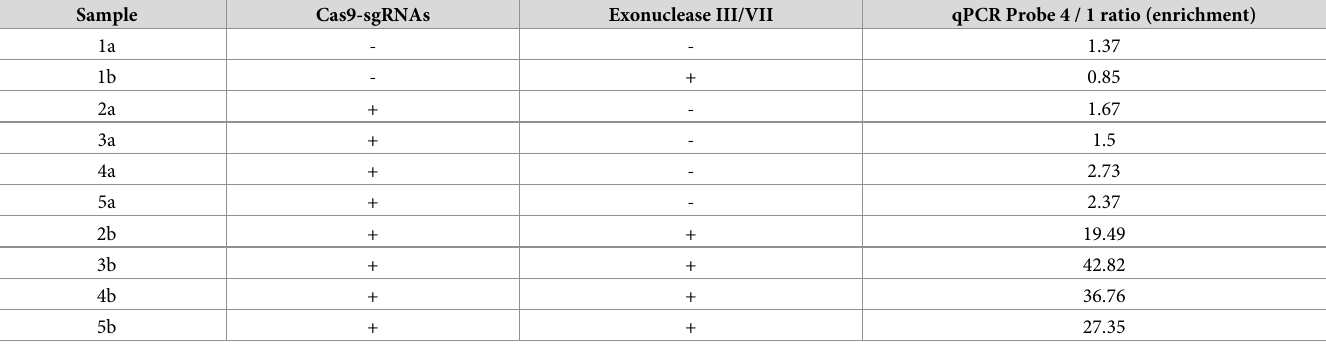
Table 1. qPCR analyses of Cas9/sgRNA Negative Enrichment protection of the target CFTR DNA fragment. Sample